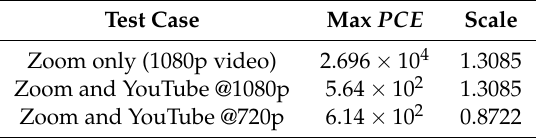
Table 6. Performance of the proposed method for different values of the aggregation threshold τ .